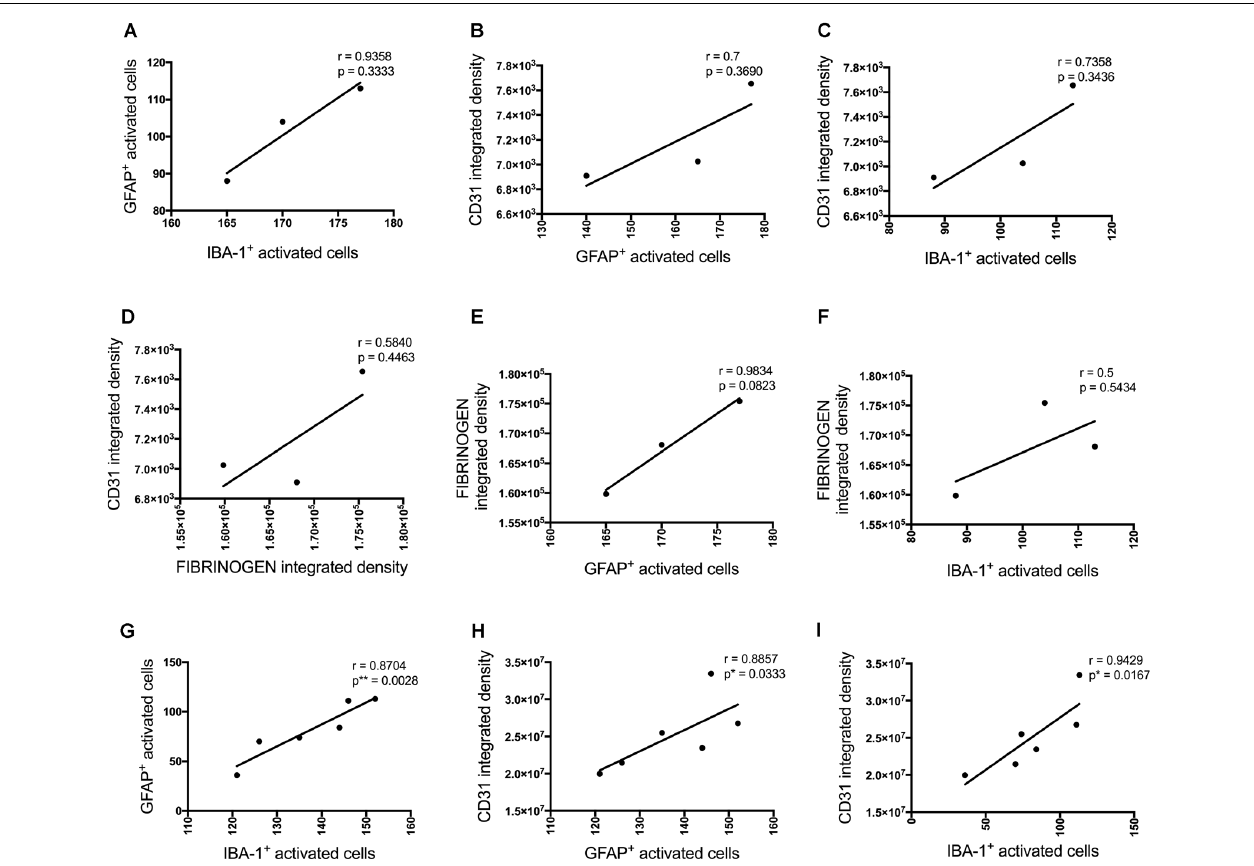
FIGURE 4 | Correlation between the number of activated astrocytes and microglia and vascular markers at the injection site ( A–F , n = 3) and a location adjacent to the injection site ( G–I , n = 6) in the CA1 hippocampal region 3 days post-injection in NC, ACSF-, scrA β 1–42 - and A β 1–42 -injected mice. This relationship is represented by a Spearman’s r -value (* p < 0.05, ** p <